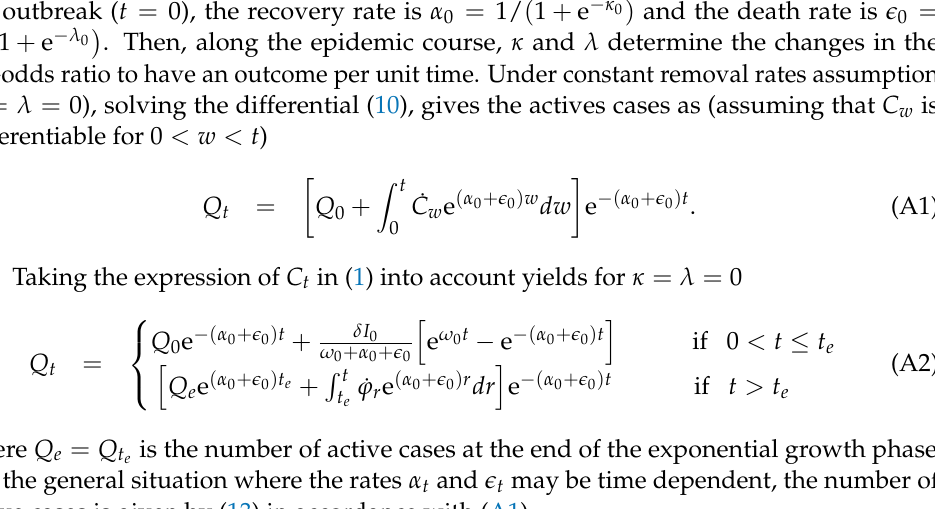
Table notes: BR, Bertalanffy–Richards; HG, Hyper-Gompertz; u p = ν ( 1 + ρ ) / ( 1 − ρν ) , t p is the root of ¨ ϕ t ; the expressions of ˙ ϕ t (growth rate) and ¨ ϕ t (growth acceleration) are given in Table